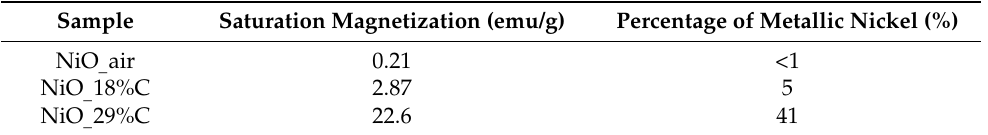
Table 3. Values of the saturation magnetization and the percentages of metallic nickel for each sample.